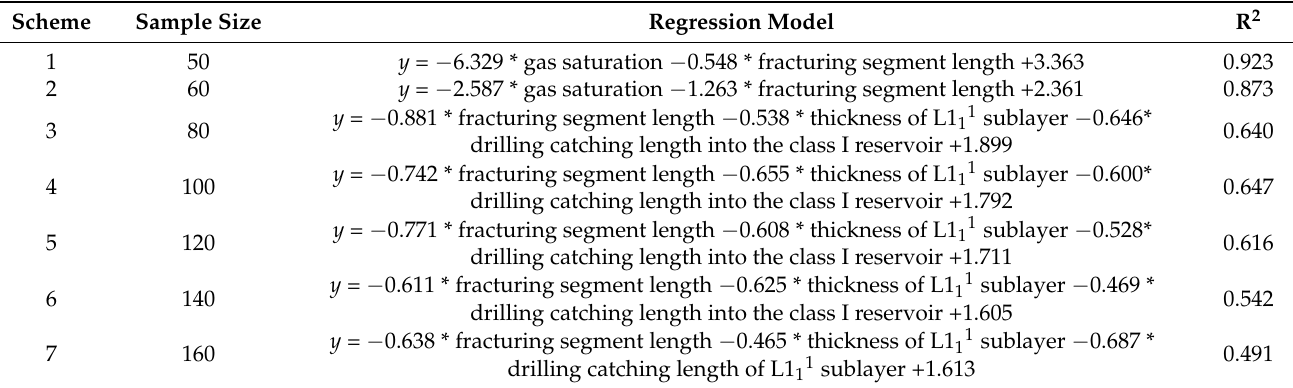
Table 6. Multiple linear regression model results.